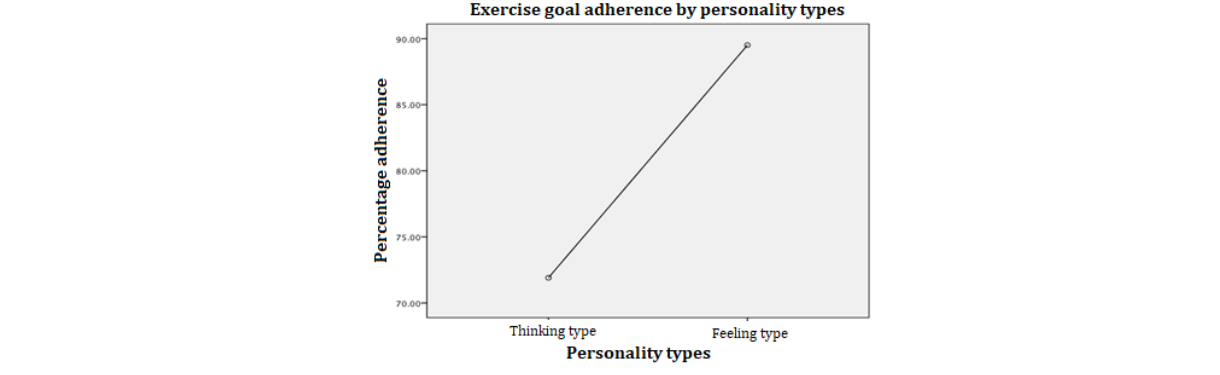
Figure 2. Personality type main effect.